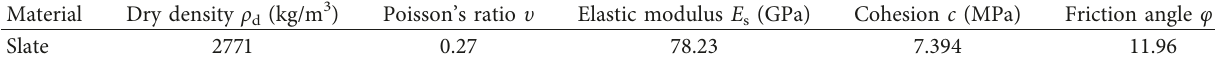
Table 2: Physicomechanical parameters of slate.